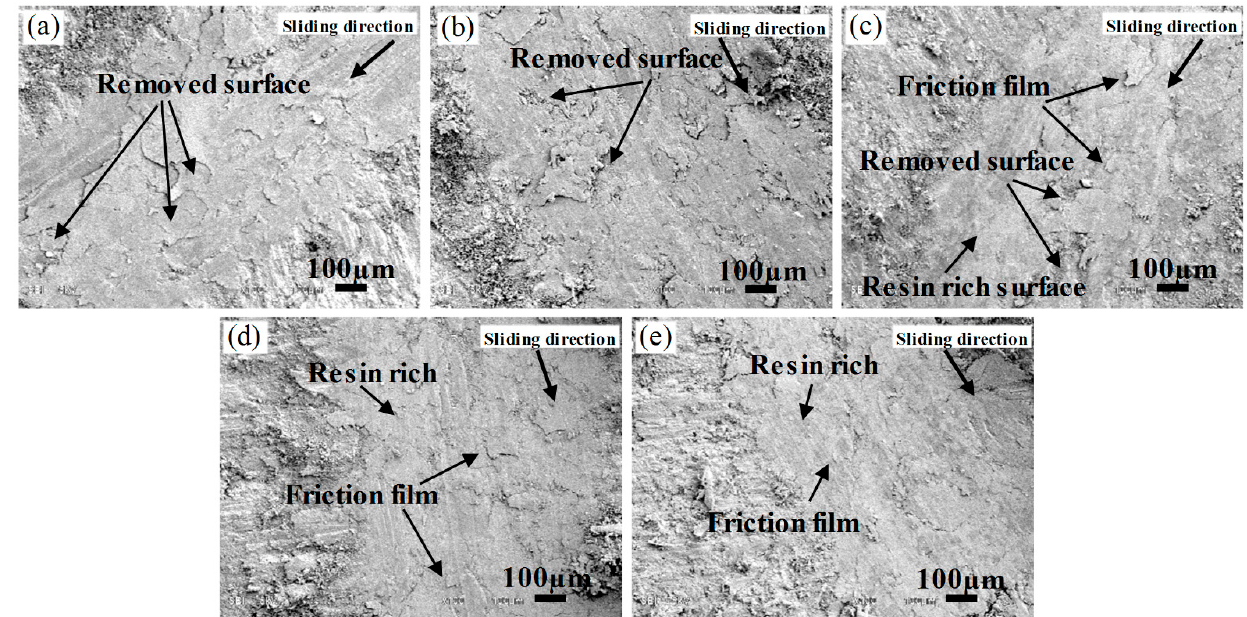
Figure 7. SEM micrographs of the worn surface after tribological testing at 25 °C of polybenzoxazine composites prepared from different benzoxazine resins: ( a ) F-BA-ot, ( b ) F-BA-pt, ( c ) F-BA-a, ( d ) F-BA-mt, ( e ) F-BA-35x.